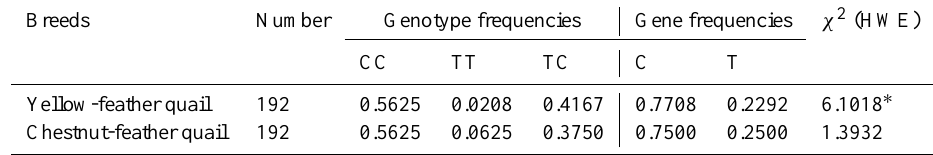
Table 2. Allele and genotype frequencies at exon 8 locus of ESR gene in two quail populations. Breeds Number Genotype frequencies Gene frequencies χ 2 (HWE) CC TT TC Yellow-feather quail 192 0.5625 192